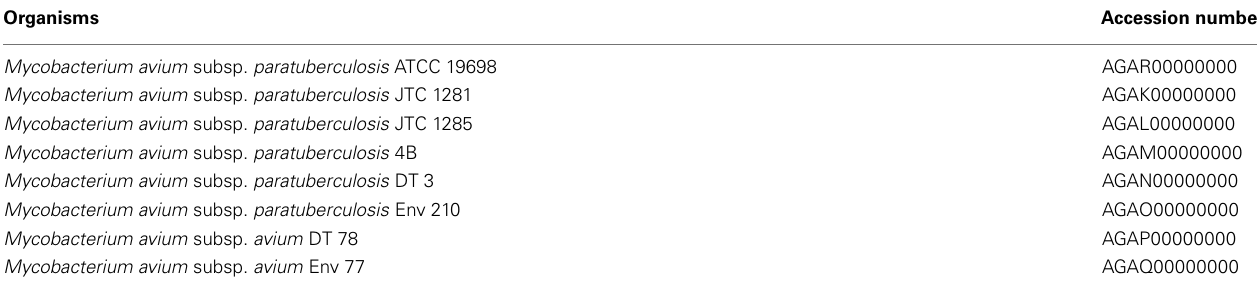
TableA1 |A list of accession numbers of genome deposited to